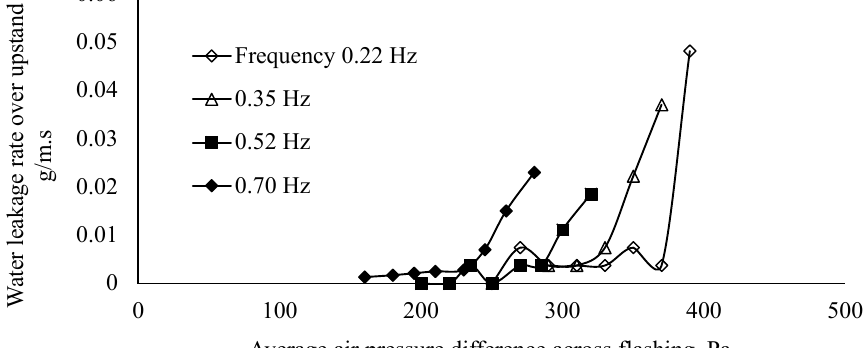
Figure 6. Steady pressure leakage characteristics of flashings with 35 and 60 mm upstands with and without hems.